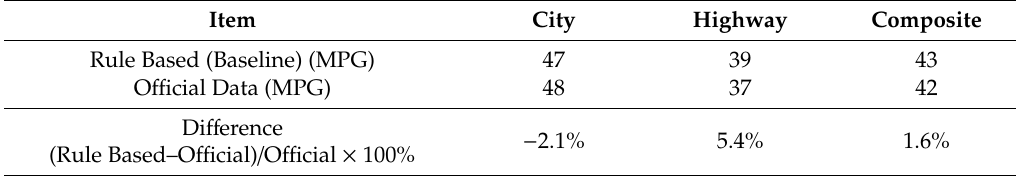
Table 3. Comparison of fuel consumption between rule-based control model (RB) and factory data.